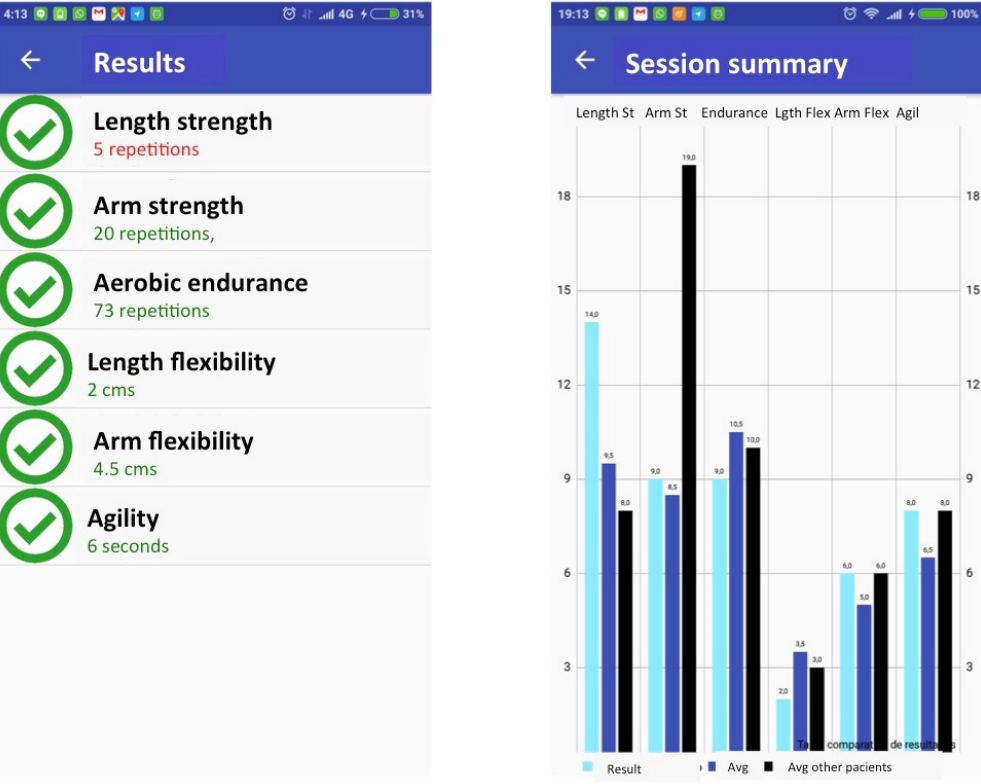
Figure 9. Results